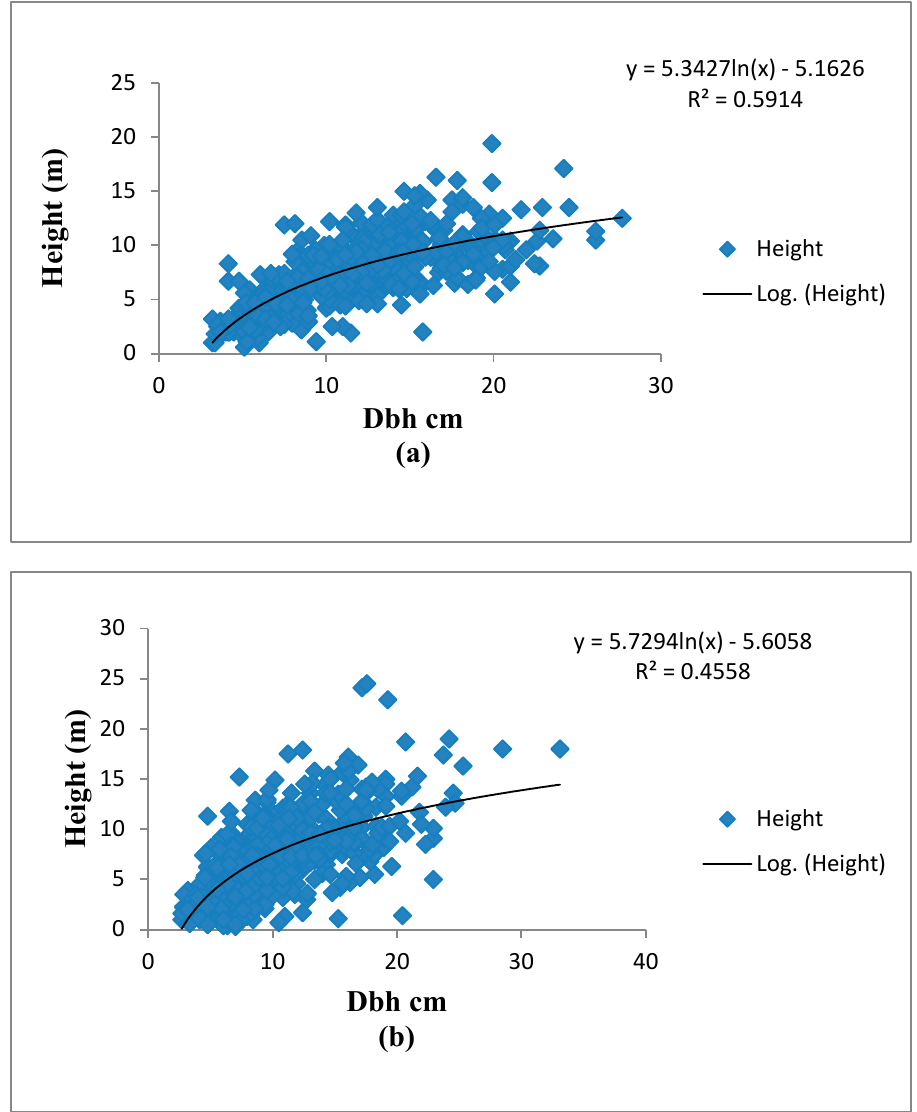
Figure 1. ( a ). Height-Diameter Allometry of the Teak stands in the Valley-Bottom stand of the Omo Forest Reserve. ( b ) Height-Diameter Allometry of the Teak stands in the Hilltop stand of the Omo Forest Reserve.